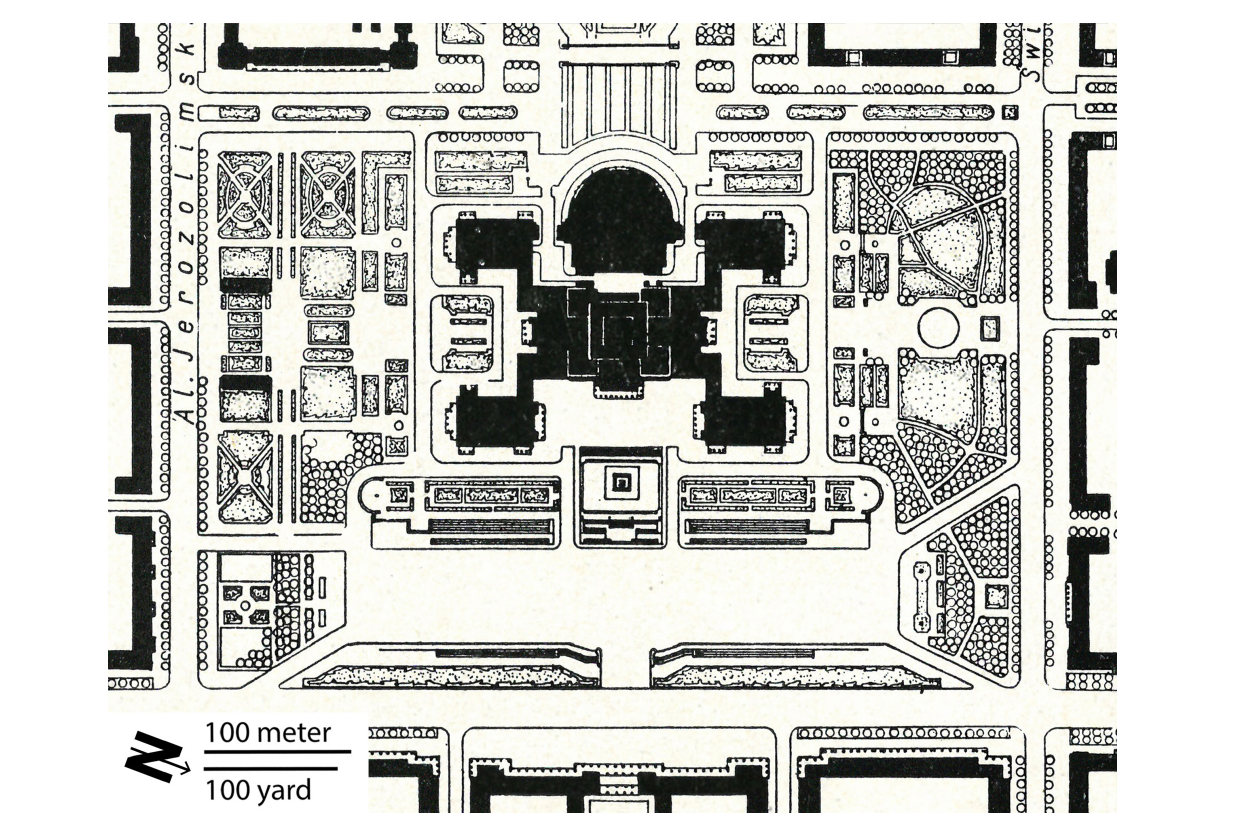
Fig. 2 . A monumental Stalin’s Square, later called Plac Defilad (Parade Square) as drawn by the architects in 1954. Until very recently, the sole steward of the vast land around the Palace of Culture and Science was the City (or a municipally owned corporation managing the Palace’s